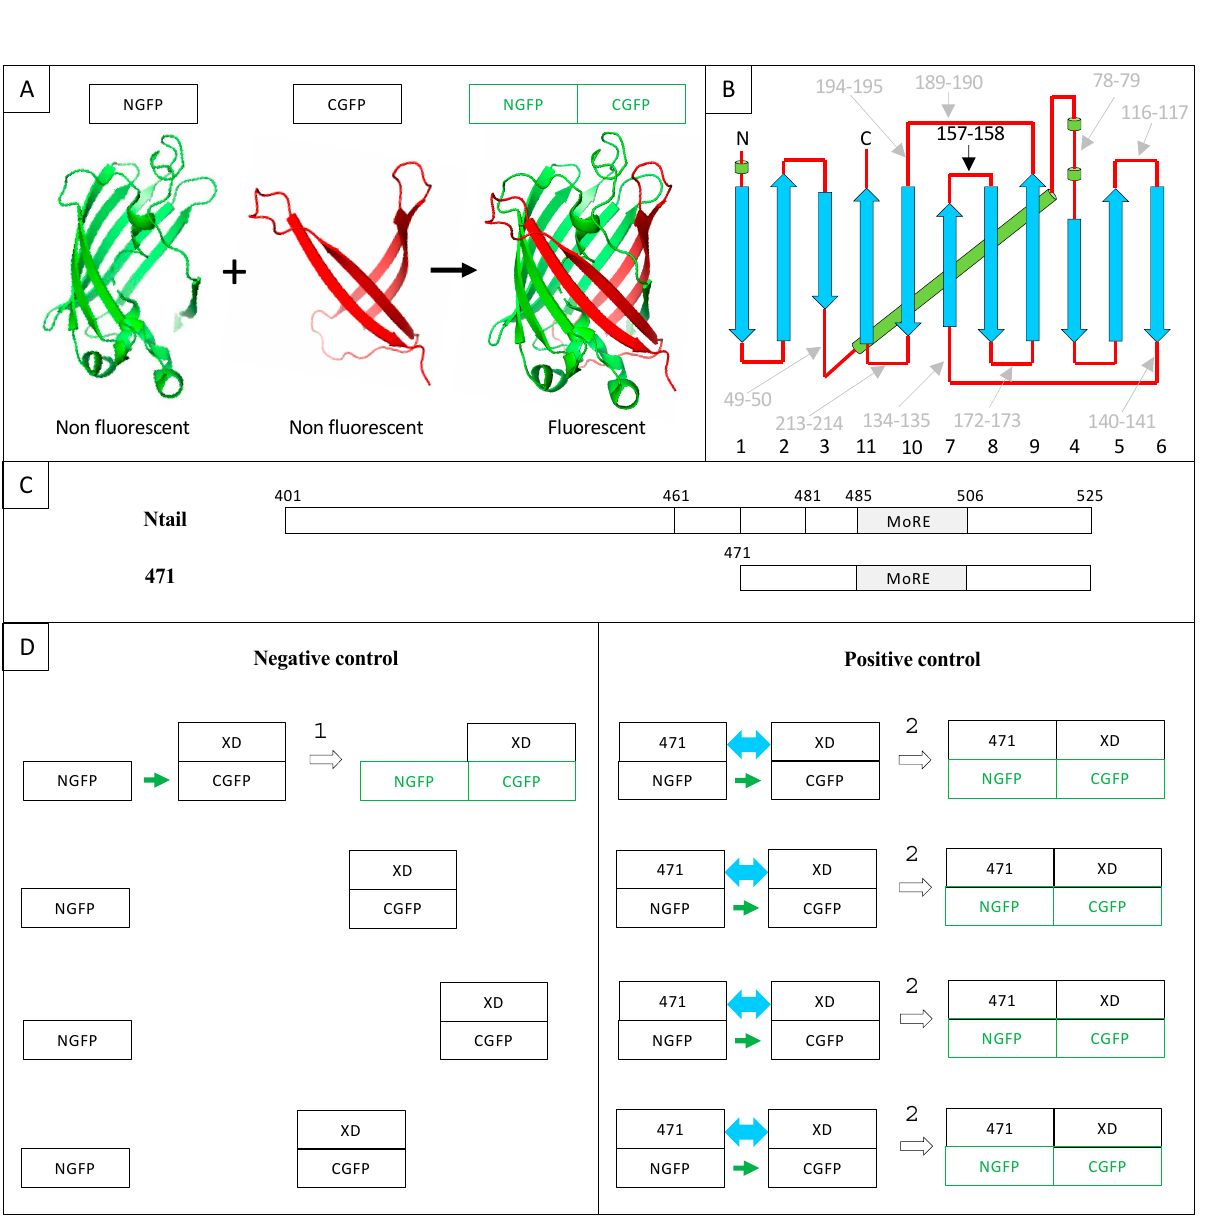
halves results in a fluorescent protein (Figure 1A). For the sake of clarity, only four potentially in- teracting molecules are represented in the following examples. (1) Negative control: since only XD is fused to CGFP, the interaction between the two GFP halves is not promoted by the high-affinity